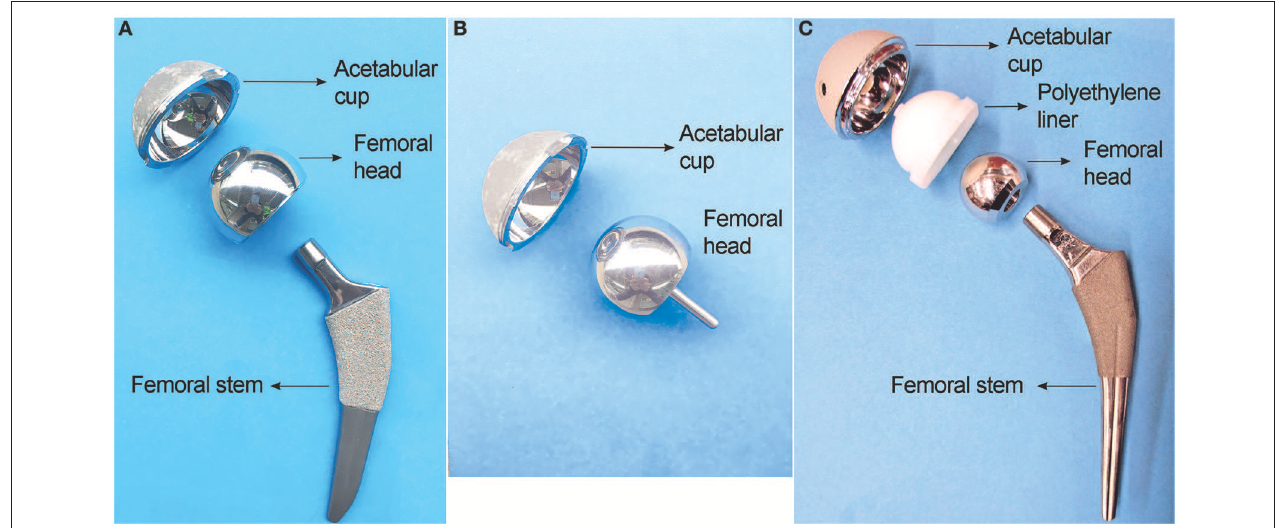
FIGURE 1 | Three main types of hip implants. (A) Large head metal-on-metal (MoM) total hip implant. (B) MoM hip resurfacing. (C) Metal-on-polyethylene (MoP) total hip implant.